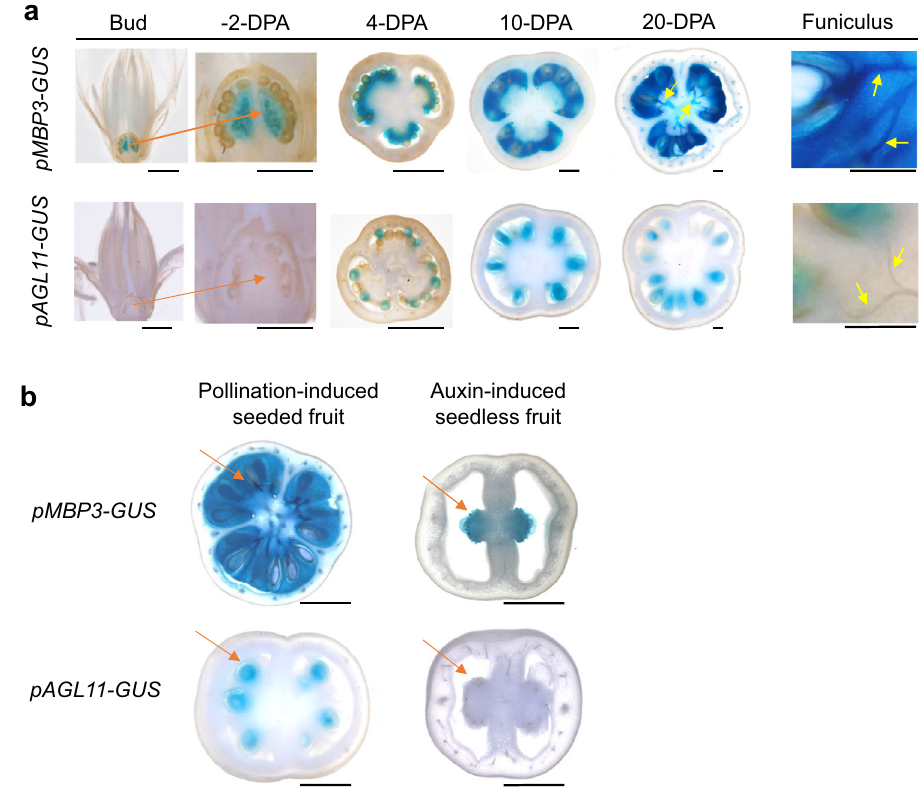
Fig. 4 SlMBP3 and SlAGL11 expression pattern throughout fruit development. a SlMBP3 and SlAGL11 expression in fl ower and developing fruit was investigated using transgenic tomato lines expressing the GUS reporter gene driven by the promoter of SlMBP3 or SlAGL11 . DPA refers to days post- anthesis; Orange arrows point to the placenta and yellow arrows to funiculus. Scale bar = 1 mm. b Expression pattern of SlAGL11 and SlMBP3 as visualized by the GUS reporter under the control of SlAGL11 or SlMBP3 promoters in pollination-dependent and auxin-induced fruit at 20-DPA stage. Unfertilized fl owers were emasculated, and the fruit set was induced either by manual pollination or by exogenous auxin treatment. Orange arrows point to the absence or presence of seeds in parthenocarpic and seeded fruit, respectively. Scale bar = 5